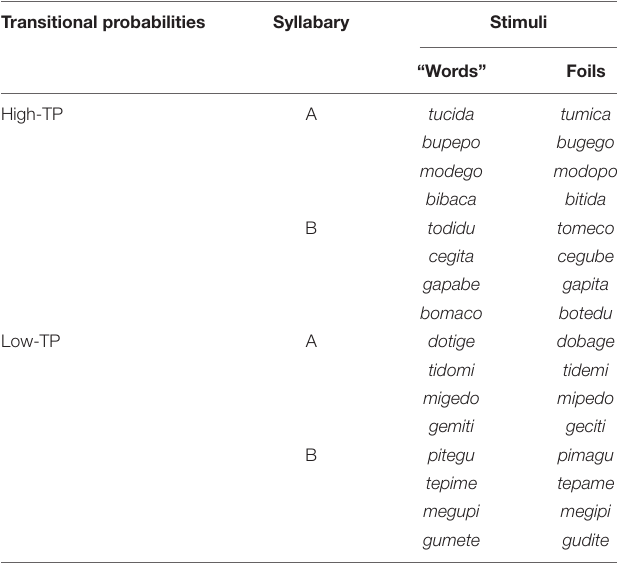
TABLE 1 | Three-syllable nonsense words and foils from Syllabary A and Syllabary B. Transitional